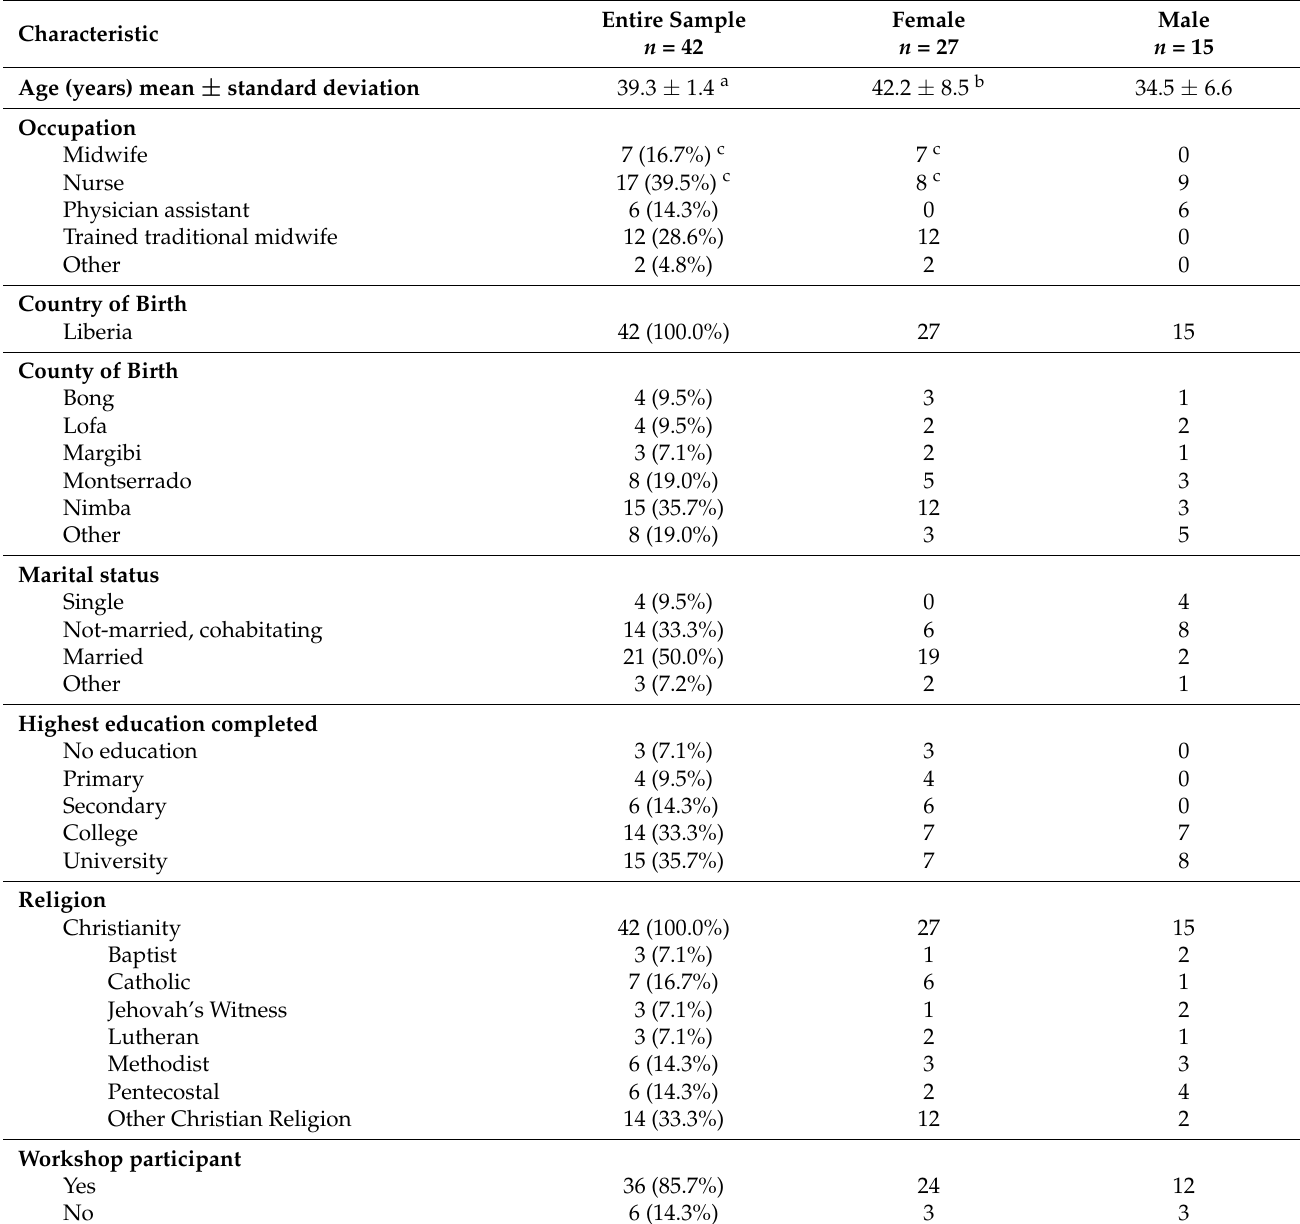
Table 2. Socio-demographic characteristics of study participants disaggregated by